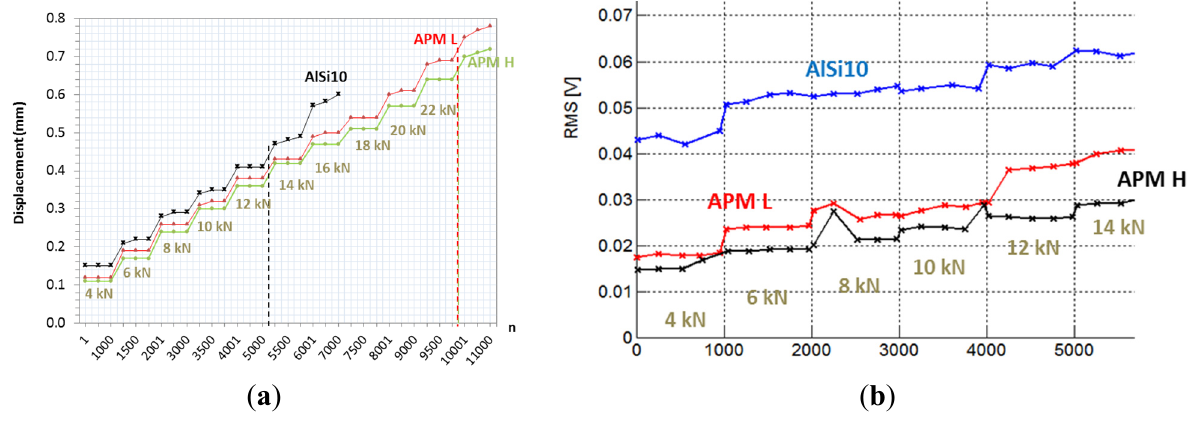
Figure 3. ( a ) Displacement vs. cycle number with staircase loading of foam-filled square tubes; ( b ) RMS of the acoustic emission vs. cycle number with staircase loading of foam-filled square